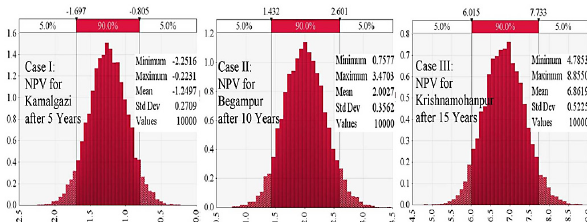
Figure 9. Distributions observed in typical simulation runs for NPV. Table 11. Parameters for WTP and NPV simulation.